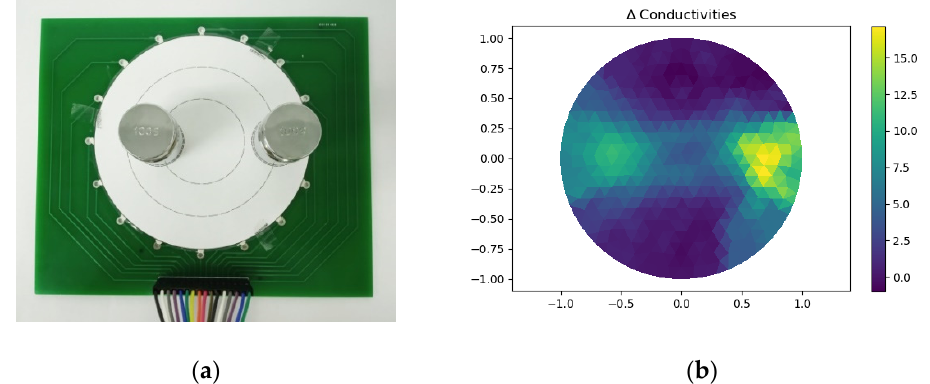
Figure 18. ( a ) Setup to test multi-object which were placed on different circles; ( b ) Reconstructed image.